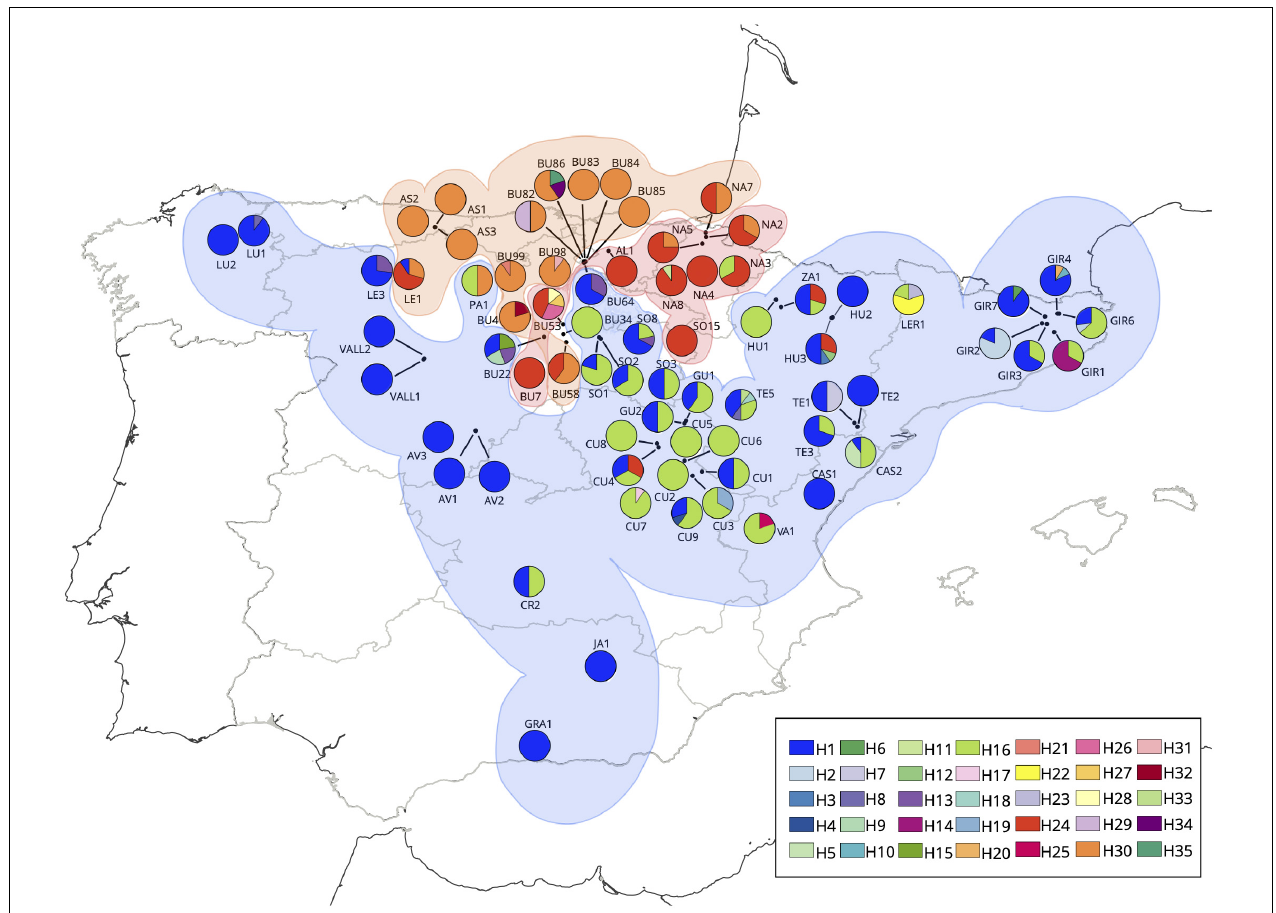
FIGURE 3 | Phylogeographic structure and haplotypes detected in the white-clawed crayfish populations of the Iberian Peninsula. Location of the three SAMOVA main groups: Central-Eastern (Group 1 in color blue), North-Western Group (Group 2 in orange color), and North-Central Group (Group 3 in red color). The haplotype’s frequencies are determined by the relative proportion of the pie graph. Each chart of the legend represents a different haplotype based on concatenated mitochondrial 16S rRNA and COI genes sequences.